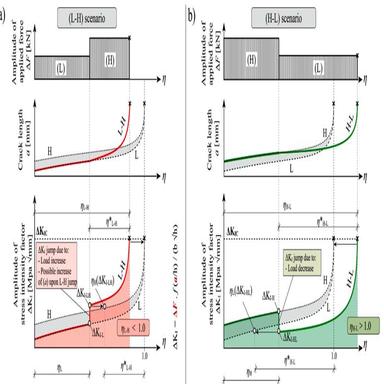
Theoretical interpretation of the observed loading sequence effect on the flexural fatigue behaviour of concrete based on the actual stress state at the crack tip: (a) Low stress level to High stress level (L-H) scenario; (b) High stress level to low stress level (H–L) scenario, adapted from. Note: ΔF is the amplitude of applied force, a is the crack length, ΔKI is the amplitude of stress intensity factor, ΔKIC is the critical stress intensity factor, η is the fatigue life, η is the remaining